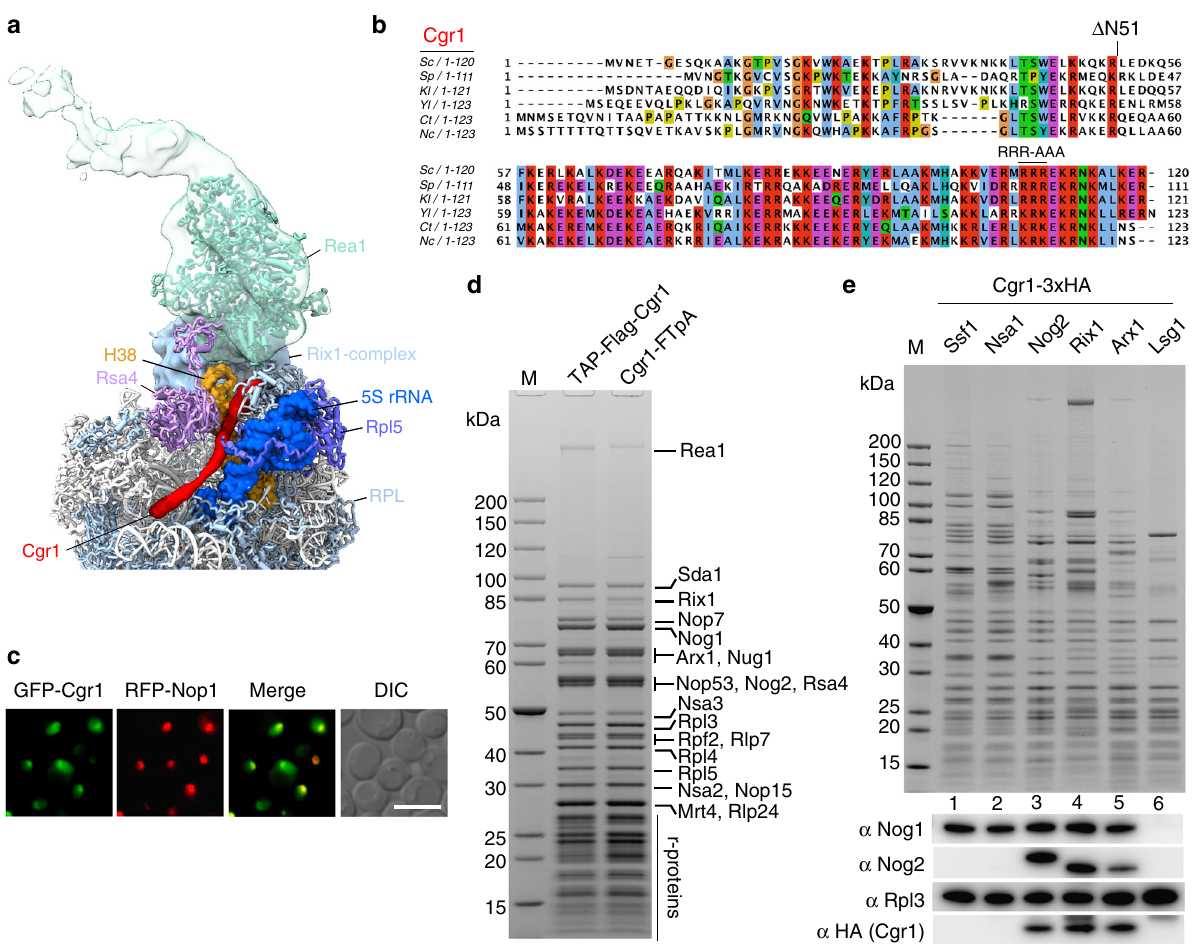
Fig. 1 The short α -helical protein Cgr1 is wedged on nucleoplasmic pre-60S particles close to the rotated 5S RNP. a Cryo-EM position of Cgr1 wedged between the β -propeller domain of Rsa4 and the rotated 5S RNP on the Rix1 – Rea1 pre-ribosomal particle (PDB: 5jcs, 24 ). The 5S rRNA (blue) and H38 of the 25S rRNA (orange) are shown as a surface models, Cgr1 (red), Rsa4 (purple), Rea1 (cyan), Rix1-complex (light blue), Rpl5 (dark blue), and other ribosomal proteins (RPL, light blue) are depicted. b Multiple sequence alignment of Cgr1 orthologues from different fungal species: Saccharomyces cerevisiae ( Sc ), Schizosaccharomyces pombe ( Sp ), Kluyveromyces lactis ( Kl ), Yarrowia lipolytica ( Yl ), Chaetomium thermophilum ( Ct ) and Neurospora crassa ( Nc ); for the sequence alignment with higher eukaryotic orthologues including human Cgr1, see Supplementary Fig. 9. Two mutant constructs, Cgr1 Δ N51 and Cgr1RRR > AAA, used for genetic interaction studies, are indicated above the alignment. c Subcellular distribution in yeast cells of GFP-tagged Cgr1 and RFP-Nop1 was monitored by fl uorescence microscopy. The localization of GFP – Cgr1 is distributed over the nucleus, with the tendency to show a slightly stronger signal in the nucleolus. Scale bar is 5 µ m. d , e Cgr1 is co-enriched on intermediate pre-60S particles typically found in the nucleus. d Cgr1 tagged either